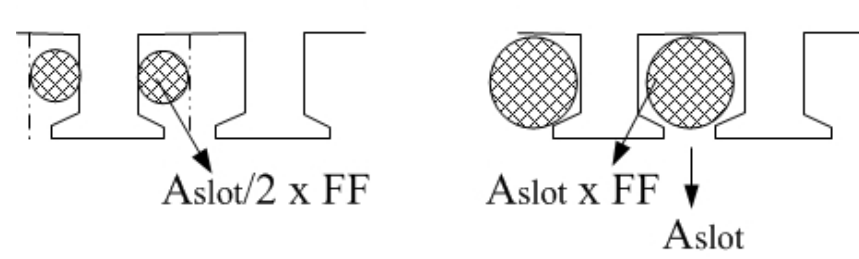
Figure 2. The demonstration of stator slots with alternate teeth winding and all teeth winding